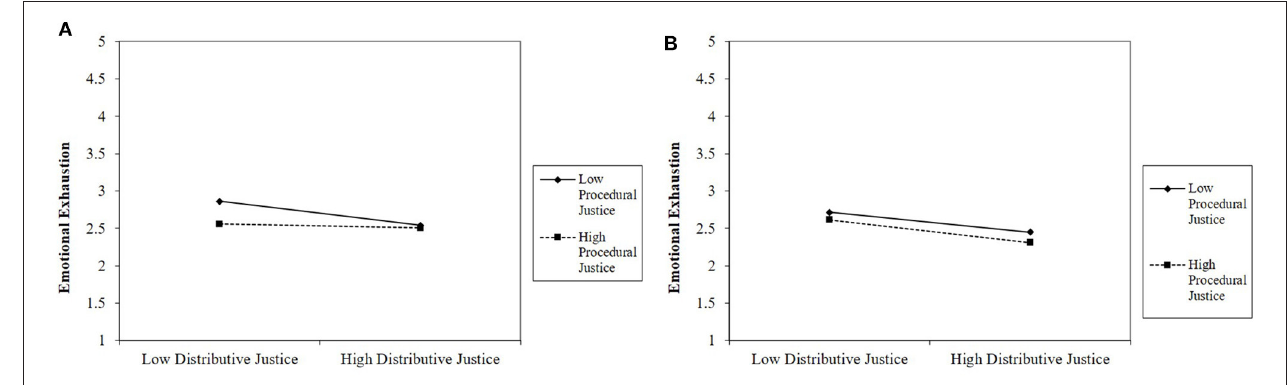
FIGURE 3 | (A) The effect of distributive and procedural justice on emotional exhaustion when job autonomy is low (Study 2). (B) The effect of distributive and procedural justice on emotional exhaustion when job autonomy is high (Study